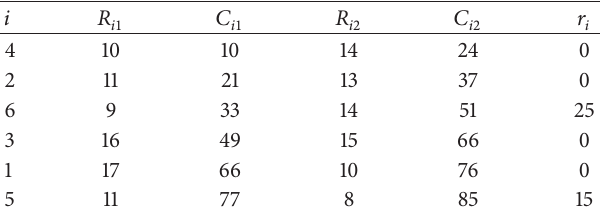
Table 3: Completion time of jobs on machines 1 and